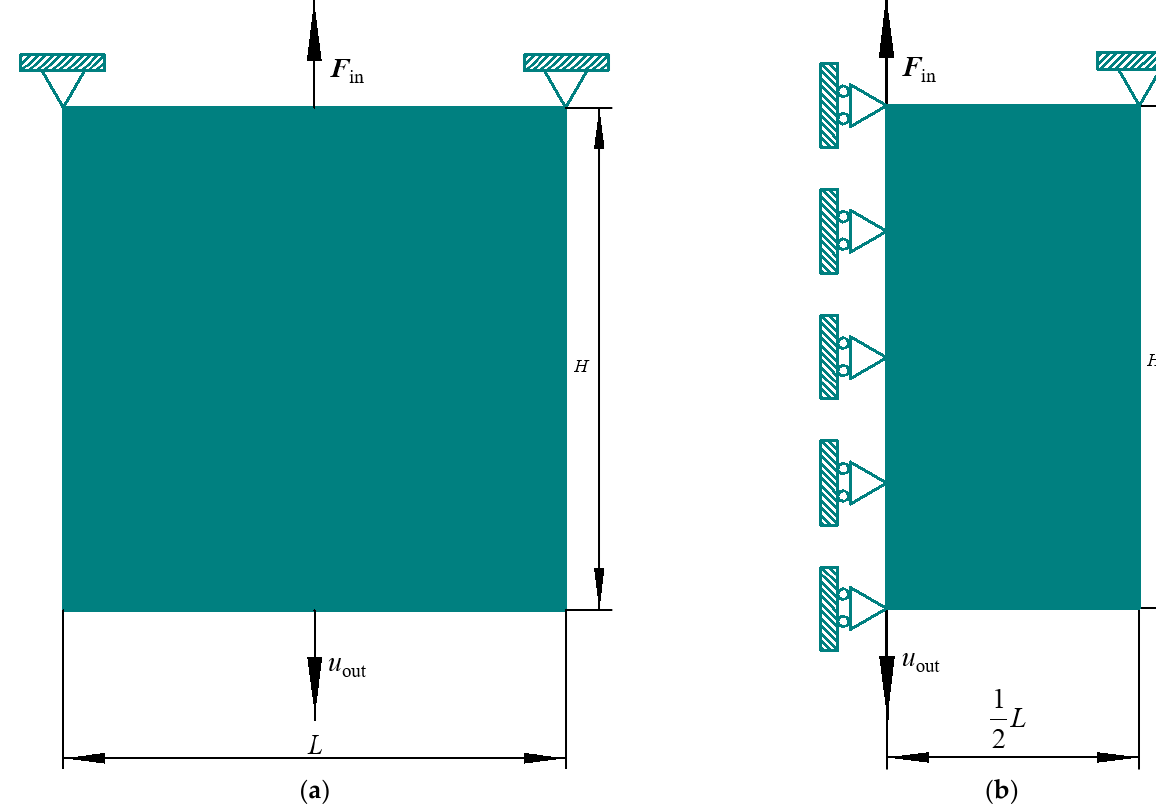
Figure 4. Original design domain for DIM: ( a ) whole design domain; ( b ) right half part. The distribution of multiple OLMs and the optimized hybrid lattice DIM (HL-DIM) are displayed in Figure 5. Lattice microstructures with various configurations are distrib- uted in designated locations to play more significant roles across the overall design do- main. As depicted in Figure 5a, OLM1 is primarily utilized in the cyanine regions, which require the relatively most compliant effective elastic properties; OLM4 with the relatively stiffest vertical or horizontal effective elastic properties is located in the gray regions. Fur- thermore, small quantities of OLM2 with inferior most compliant effective elastic proper- ties and OLM3 with subordinate stiffest vertical or horizontal effective elastic properties are separately placed in the transitional orange and magenta regions. The partial